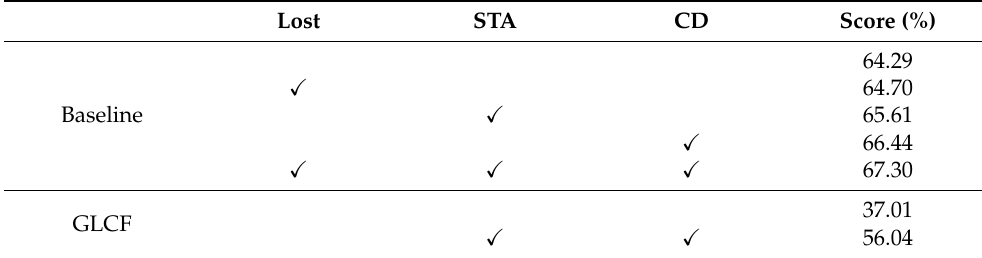
Table 2. Ablation studies on components of SiamSTA. Lost: lost estimation, STA: spatio-temporal attention, CD: change